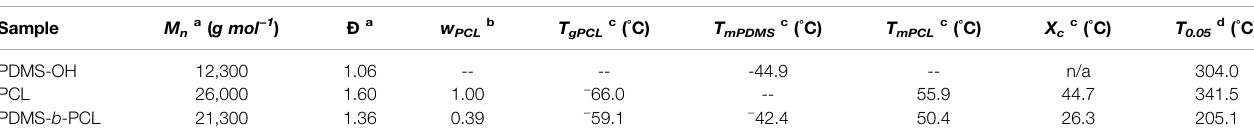
TABLE 1 | Thermal characterization of synthesized polymers.